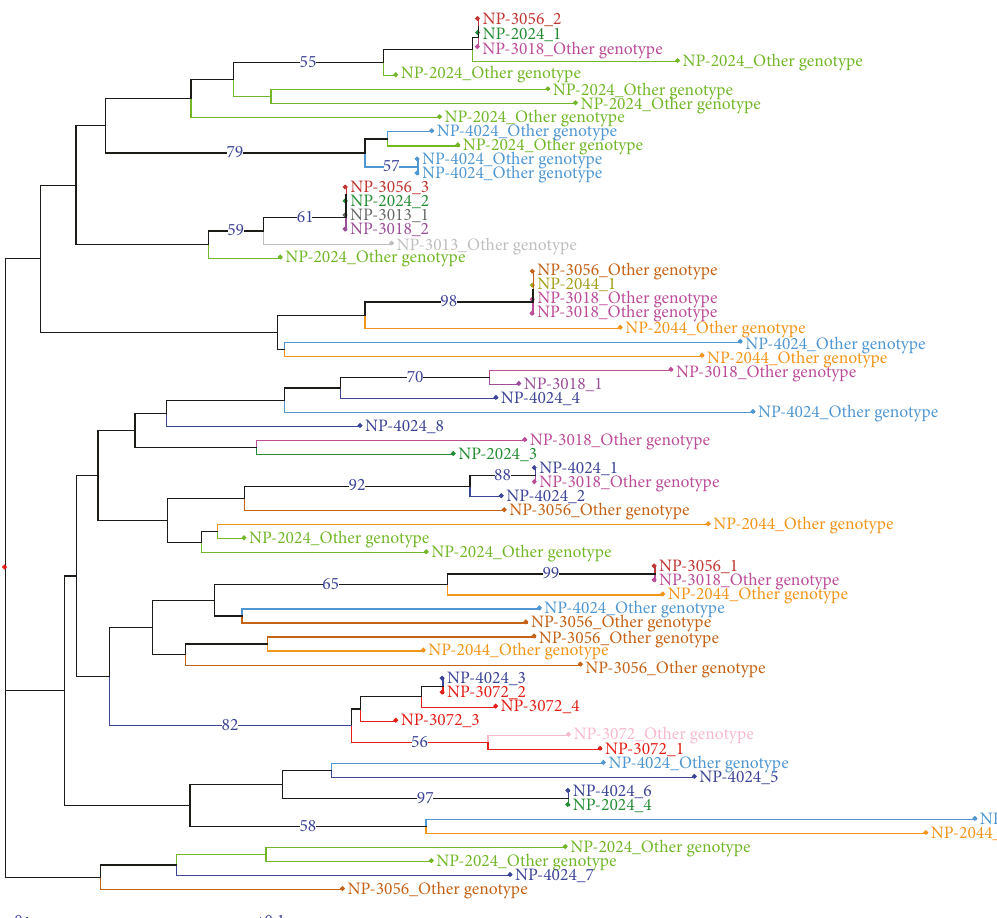
Figure 4: Dissimilarity analysis of 7 “clonal accessions” from the EECA station in 2013. NJ-Tree on the 63 different unique genotypes using 12 SSR markers. Branch support is expressed in percent of presence after 10000 bootstraps (values above 0.5 are